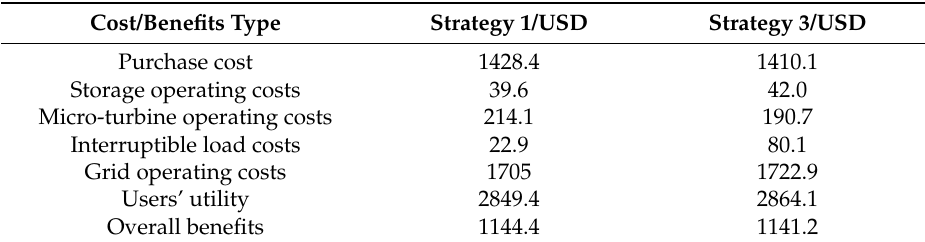
Table 4. Cost and benefit of Strategy 1 and Strategy